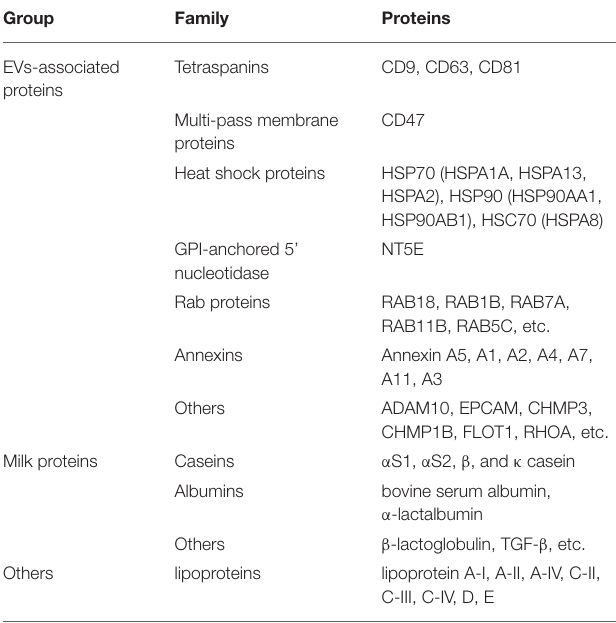
TABLE 2 | Summary of BM-EVs proteome profiling.